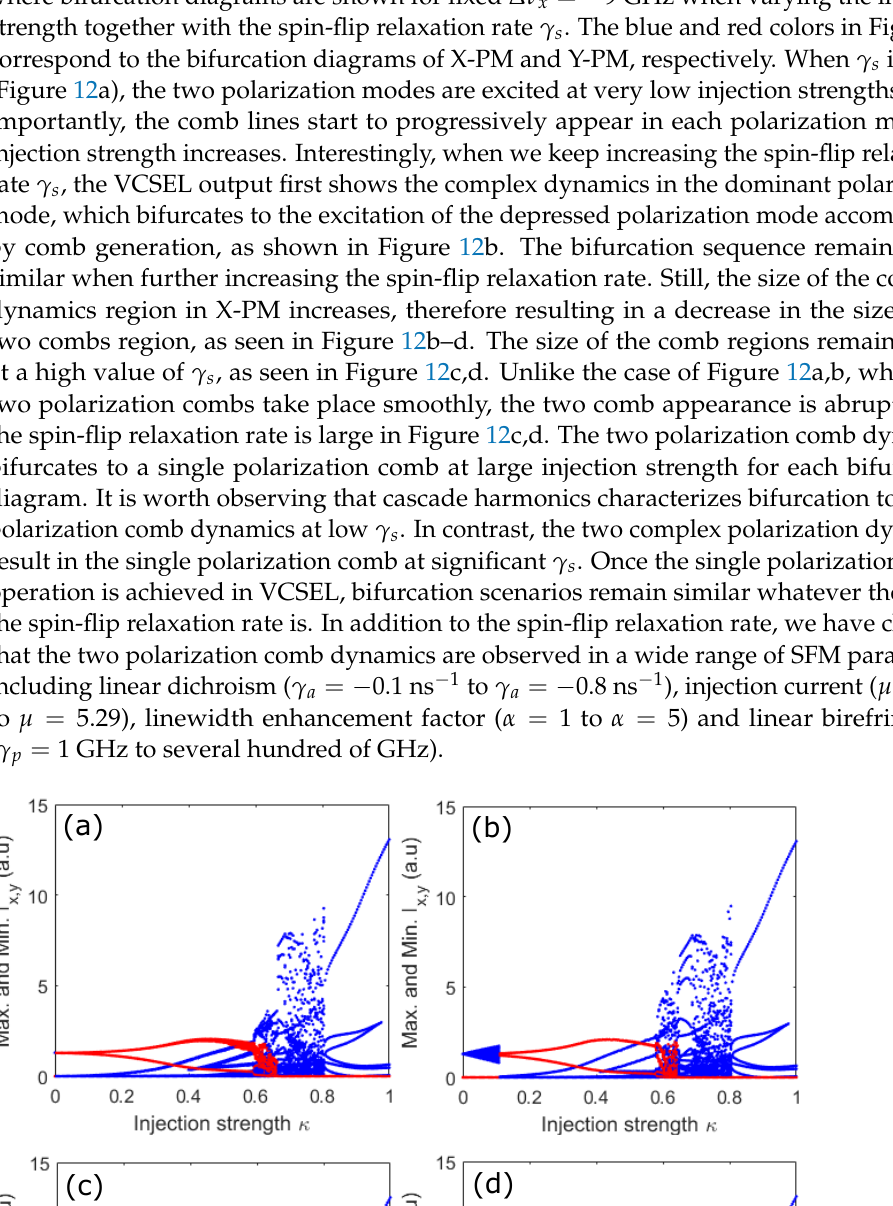
− 1 , γ − 1 , γ − 1 s = 200 ns s = 1000 ns